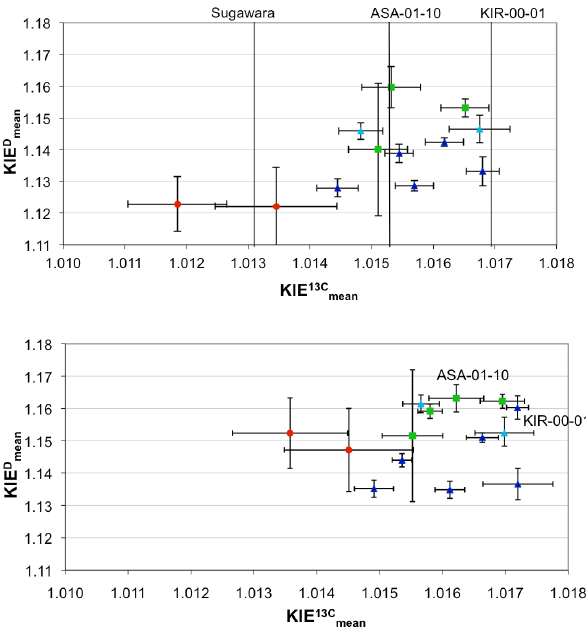
; mid-latitudes: green ; Arctic ; Arctic ). KIR-00-01 and ASA-01-10 in the bot- 48 - 54 / 63 - - 54 / 63 - - 54 / 63 - - 54 / 63 -